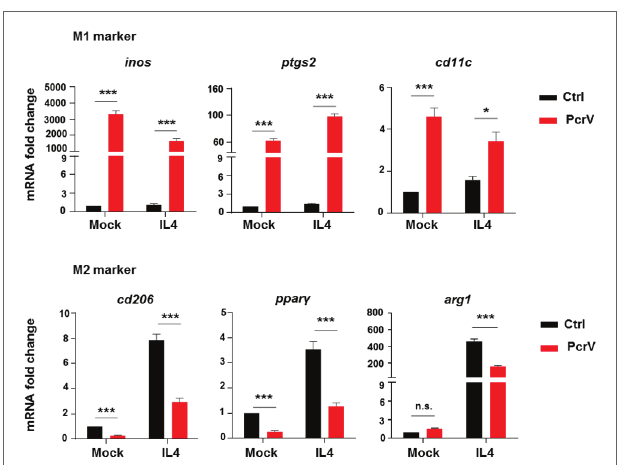
FIGURE 4 | PcrV repolarizes macrophages from M2 to M1 phenotype. BMDMs pretreated with 20 ng/ml of IL4 for 12 h were primed by PcrV (10 μ g/ml) for another 24 h. Macrophage M1 and M2-related genes were analyzed by RT-qPCR. An unpaired Student’s t test was used for statistical analysis. * p < 0.05; *** p < 0.001; n.s. indicates no